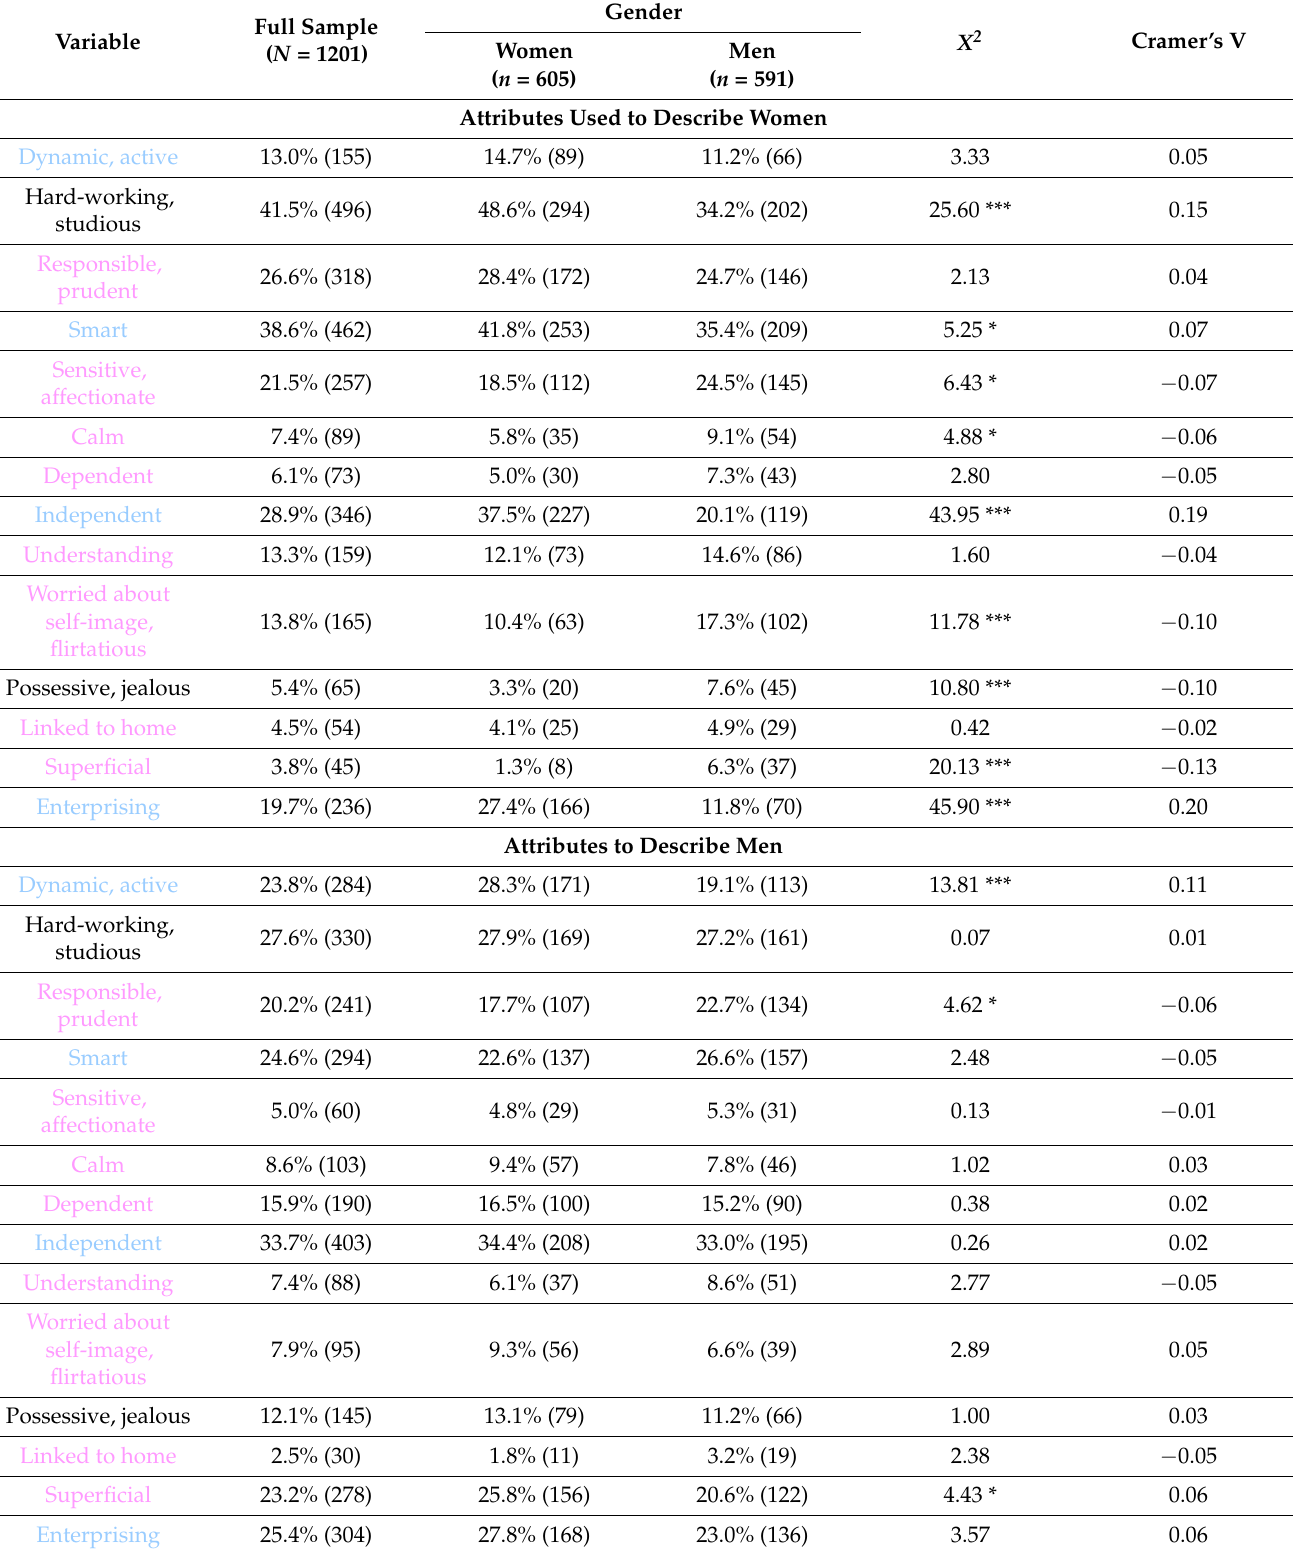
Table 2. Attributes selected to describe women and men by